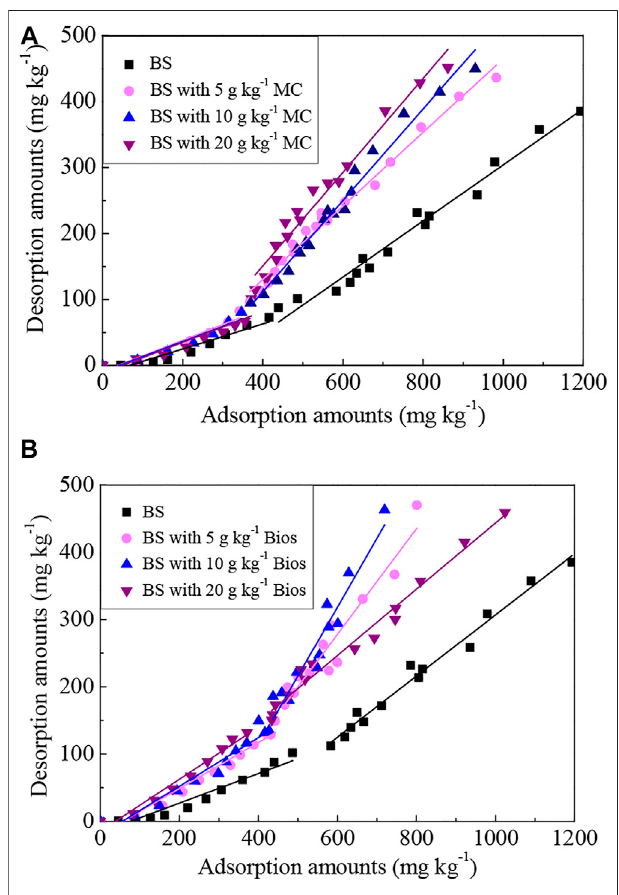
FIGURE 3 | P desorption from soils incubated with different contents of organic matter derived from (A) manure compost and (B)